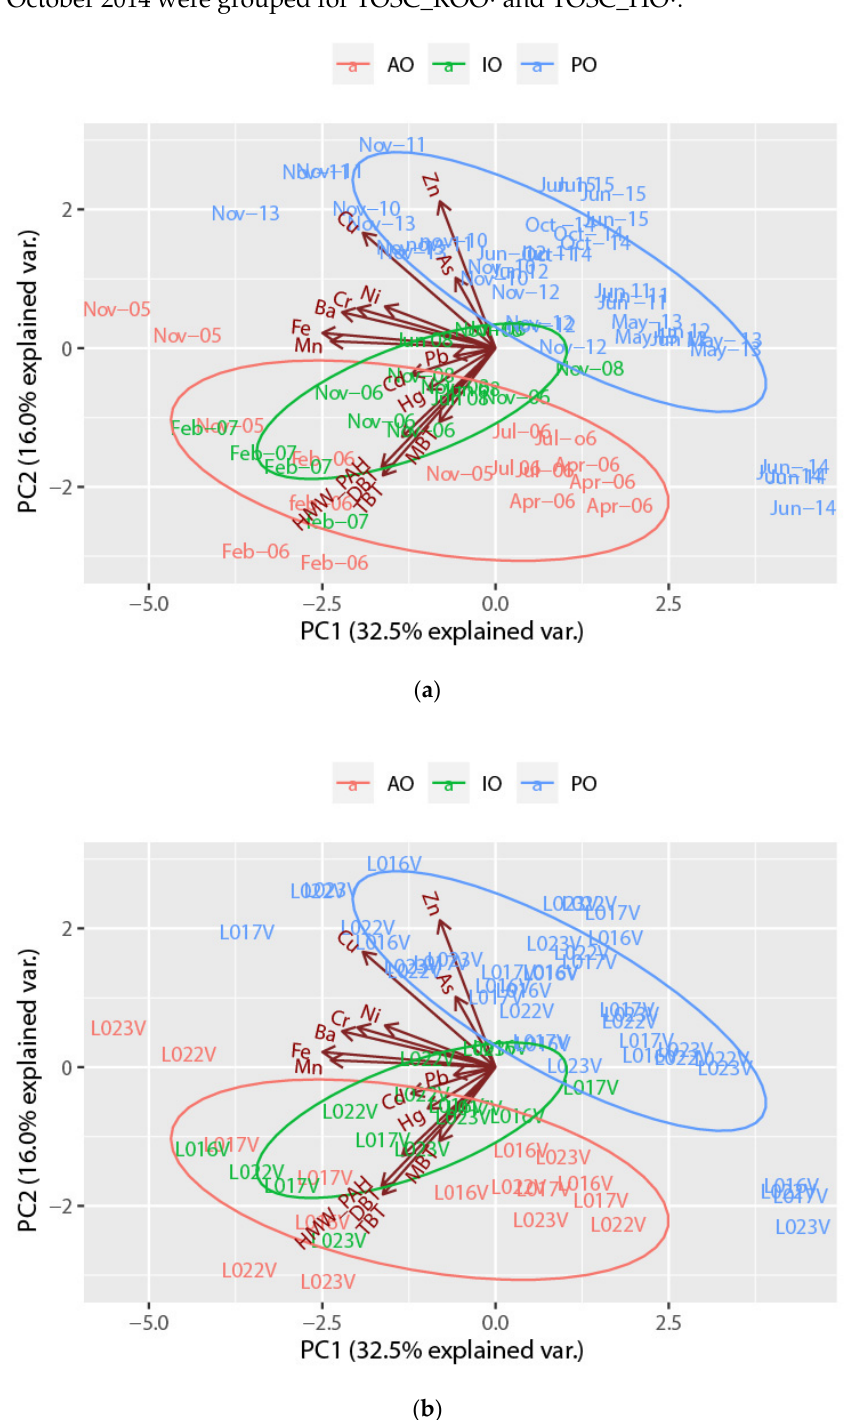
Figure 2. Biplots of the Manila clam samples, and the loadings of bioaccumulation data, labelled as ( a ) surveys and ( b ) sites, on the first two principal components. (AO = ante operam , IO = in opera , PO = post operam ).